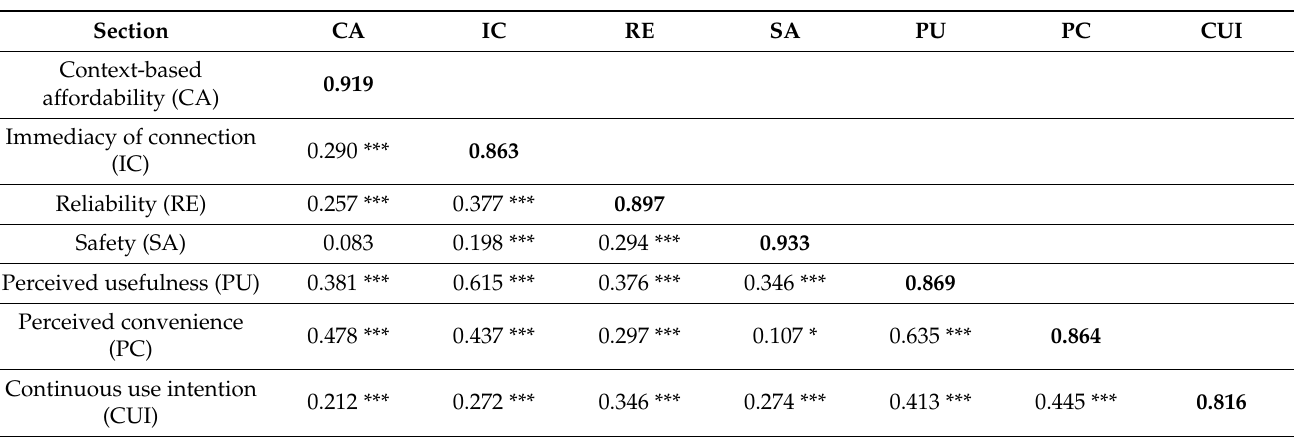
Table 5. Discriminant